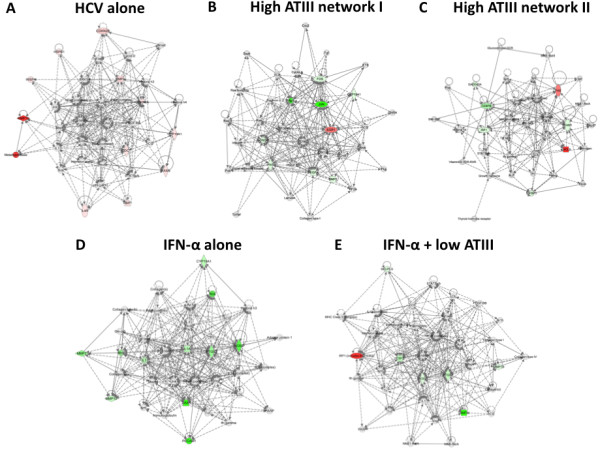
Interactive network analysis of HCV, ATIII and IFN-α altered hepatocyte genes. (A) Network with nodules and significant genes altered by HCV. (B and C) Two highest scoring network (out of three) with nodules affecting genes activated by high dose (58 μM) ATIII treatment of the HCV replicon. (D) Network with nodules and significant altered genes after IFN-α treatment of the HCV replicon. (E) Network with nodules and significant altered genes after IFN-α and low dose (7 μM) ATIII treatment of the HCV replicon. Pathway analysis was done using Ingenuity Pathways Analysis Software with significant (P<0.05) up-regulated (red) and down-regulated (green) genes indicated. Nodules (double circles) are genes with a reported influence on genes altered by HCV, ATIII or IFN-α. Significance was calculated using the ΔΔCt method for three independent experiments.